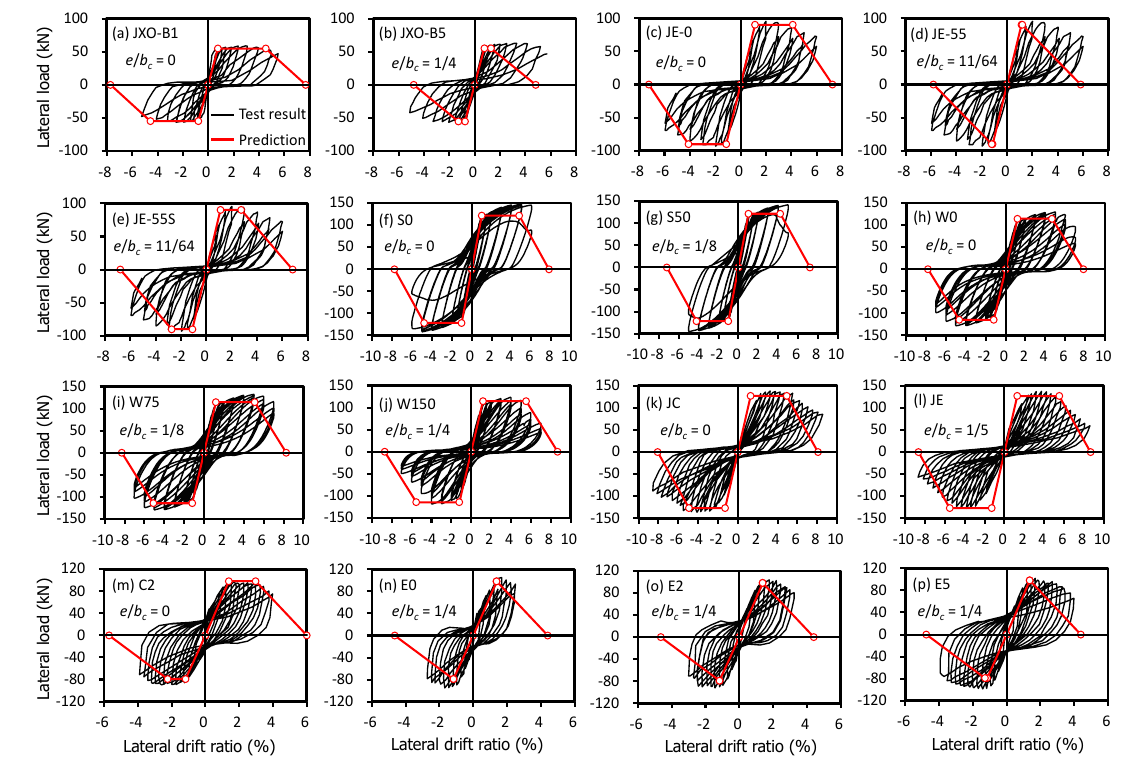
Figure 6. Comparison between test results and predictions with ACI 318-19.